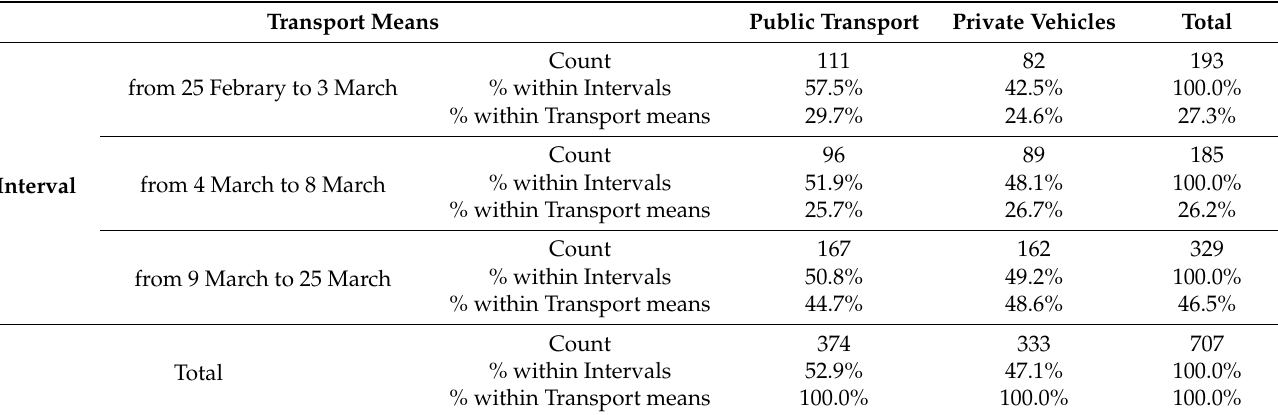
Table 5. Time interval in relation to participants’ transport means.